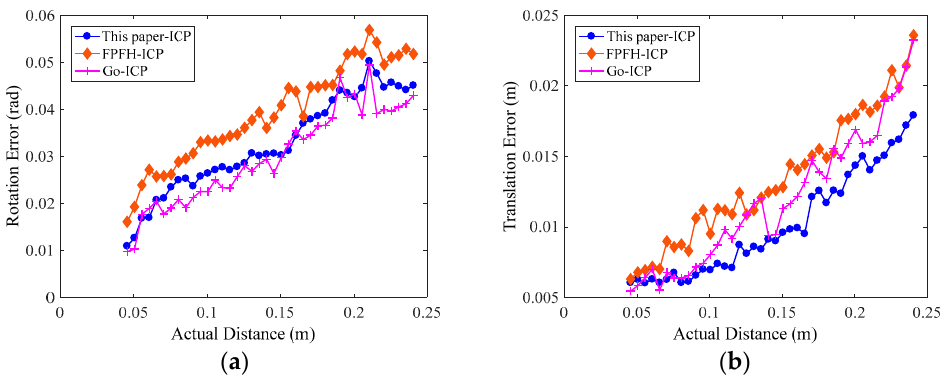
Figure 12. Errors of the pose estimation with the semantic segmentation results of FCN-atrous-2s. We set the actual Euclidean distance of the robot end-effector in the corresponding two different poses as the abscissa. ( a ) The rotation matrix errors obtained using the three registration methods fluctuate with an increasing distance. ( b ) The translation errors increase with an increase in the actual distance, but their fluctuation is also relatively large.